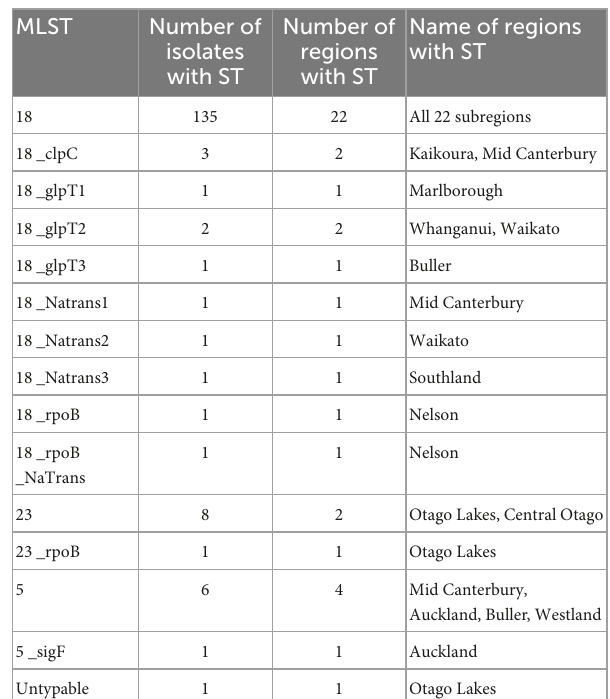
TABLE 1 Regional distribution of multilocus sequence types (MLST) of Paenibacillus larvae in New Zealand.